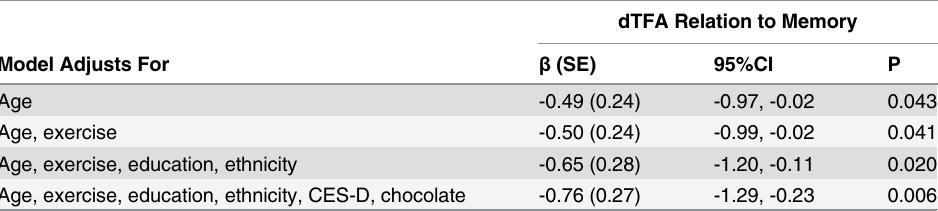
attenuate significance of the dTFA prediction. Of relevance, SBP, waist circumference and BMI did not themselves significantly predict memory performance, suggesting that mechanisms by which dTFAs affect BMI (rather than BMI itself) may also affect memory impairment, further supporting use of these terms as ( proxies for ) mediators, rather than as confounders. The rela- tionship remained (just) significant with adjustment for these three predictors separately and Table 2. Dietary Trans Fat Relation to Memory, Stratified by Age: Men Age < 45.